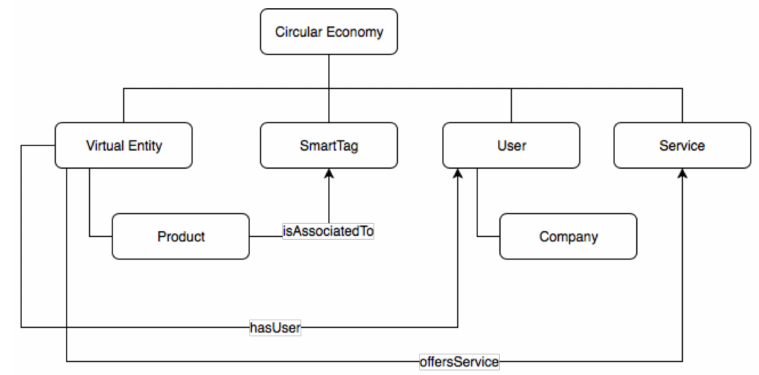
Figure 18. Circular Economy concepts and